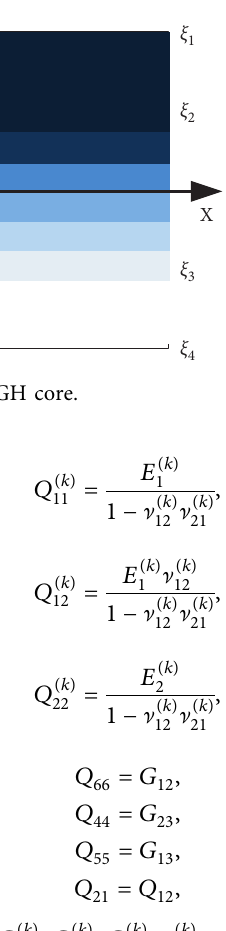
where E ( k ) , E ( k ) , G ( k ) , G ( k ) , G ( k ) , ] ( k ) , and ] ( k ) are the elastic 1 2 12 13 23 12 21 modulus, shear modulus, and Poisson’s ratio of the skin and core layer, respectively. The superscript k � 1 , 3 represents the upper and lower surface. The parameters are from equation (3). k � 2 represents the honeycomb core layer. The equivalent elastic parameters of the honeycomb core layer are calculated by formula (5).